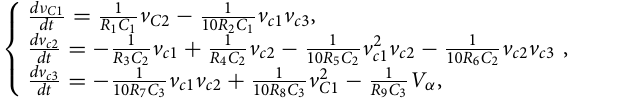
Figure 8. The local basins of attraction in three different planes. ( a ) The x ( 0 ) z ( 0 ) plane with y ( 0 ) The x ( 0 ) −